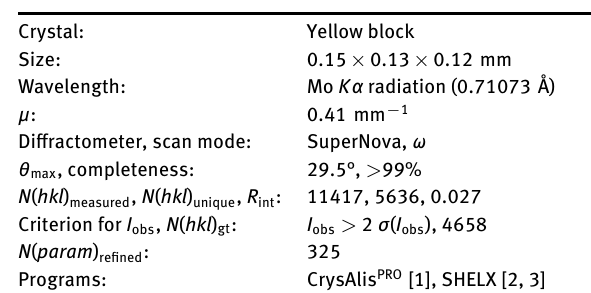
Table 1: Data collection and